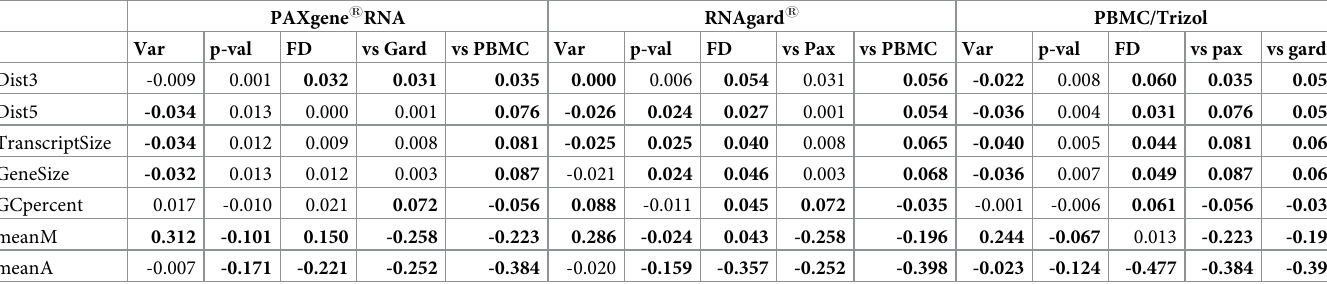
Table 2. Correlation of within donor and preservation method probe error with probe properties.